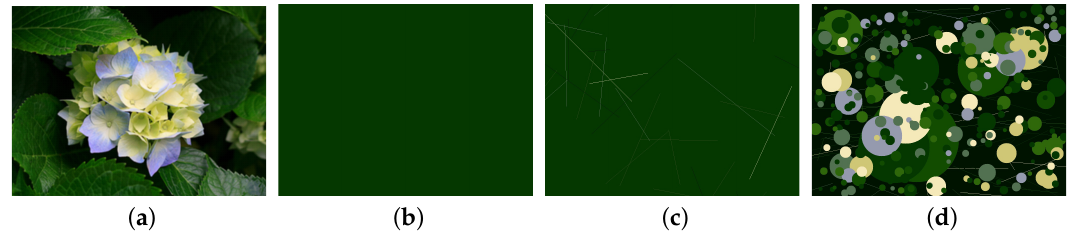
Figure 6. ( a ) An original picture; ( b ) Drawing background color; ( c ) Drawing lines; ( d ) A complete picture generated through algorithm